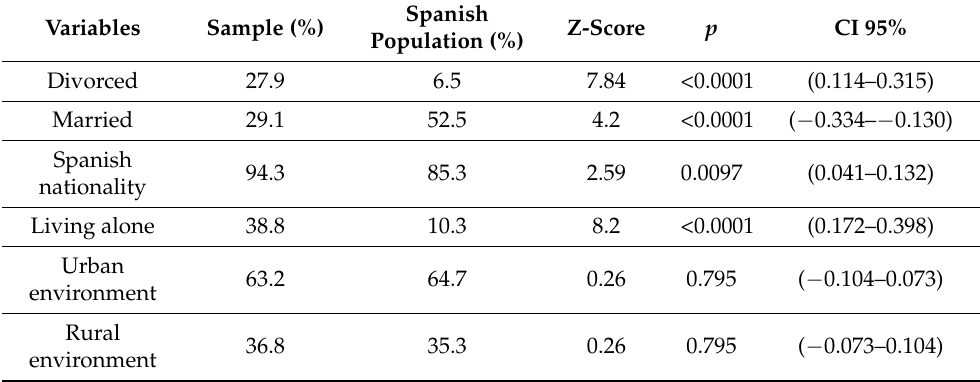
Table 1. Comparison of proportions between cases in our sample and the Spanish population (according to INE’s